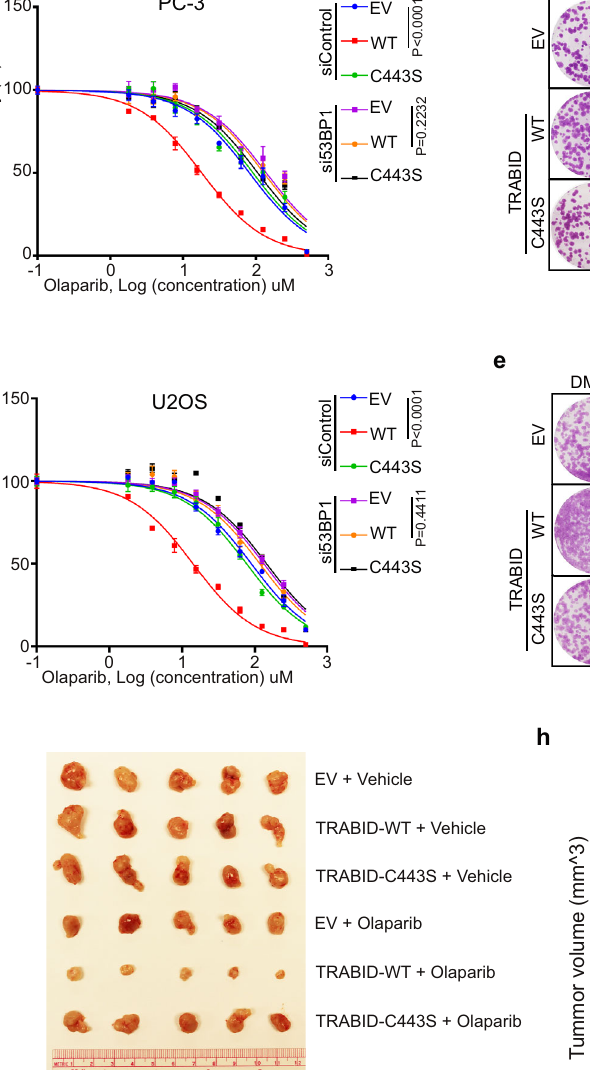
quanti fi cation data shown in ( d , f ). Data were presented as the mean±SD of three independent experiments. Two-tailed unpaired Student ’ s t -test. P value were pro- vided in the fi gure. g , h . PC-3 cells infected with lentivirus expressing EV, TRABID- WT, or TRABID-C443S were injected s.c. into the right fl ank of SCID mice and treatedwithvehicleorolaparib(50mg/kg).Tumorgrowthwasmeasuredevery fi ve days for 30 days. Tumors in each group at day 30 were harvested, photographed and shown in ( g ). Data in ( h ) are shown as mean±SD ( n =5). Two-tailed unpaired Student ’ s t -test. P value were provided in the fi gure. Comparing the size of tumors in different groups at day 30. Source data are provided in this